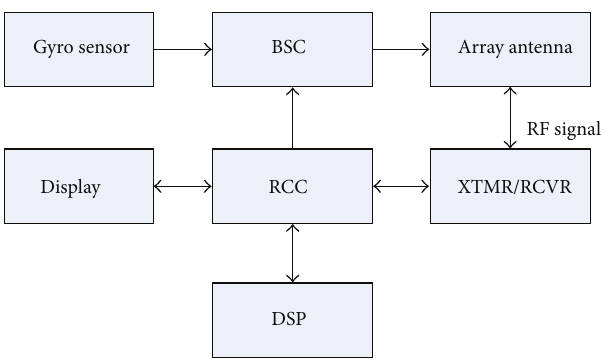
Figure 1: High level structure of shipborne phased array radar.